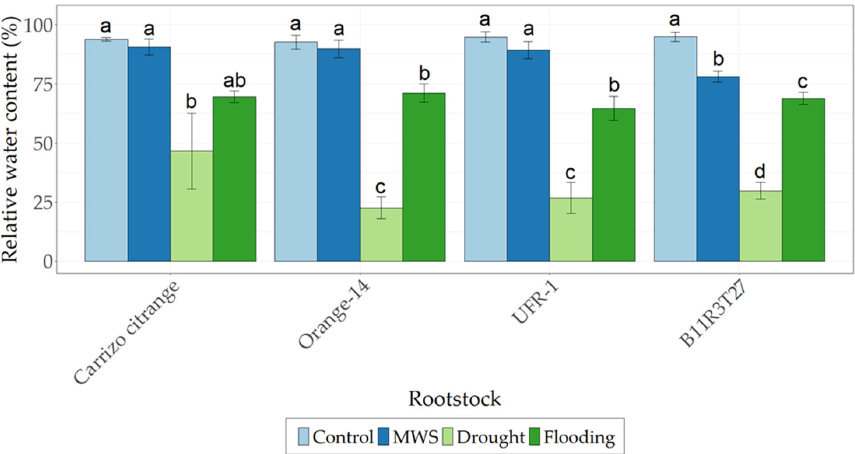
Figure 2. Mean relative water content (RWC; %) on four citrus rootstocks (Carrizo citrange, Orange-14, UFR-1, and B11R3T27) under four water conditions treatments (Control, MWS, Drought, and Flooding) at the end of the experiment. Values in columns with different letters denote statistical differences among the treatments per each citrus rootstock by LSD-Fisher’s test ( p < 0.05). MWS: Mild water stress.